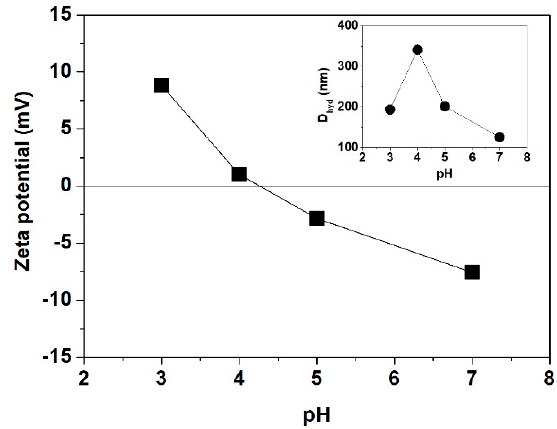
Figure 1. Dependence of the Zeta potential of SF on pH. The inset plot shows the hydrodynamic diameter ( D hyd ) of SF aggregates at different pH (taken from [35]).